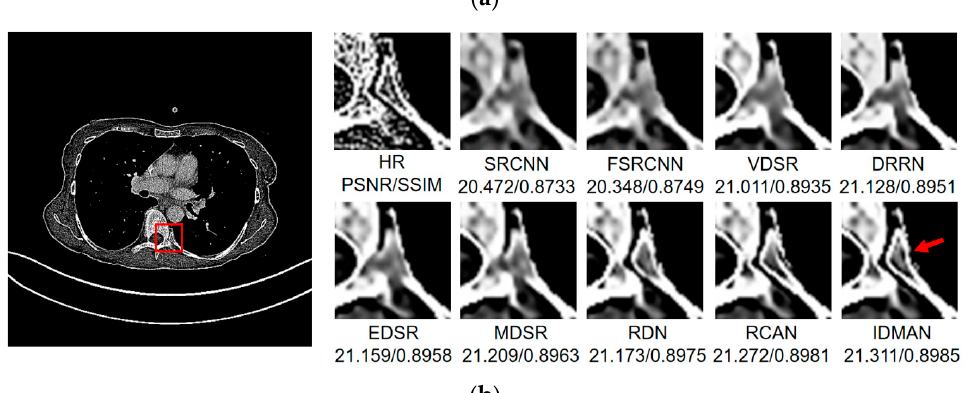
Figure 9. Images ( a , b ) show the visual results of different algorithms on DeepLesion testing set for scaling factor × 3.